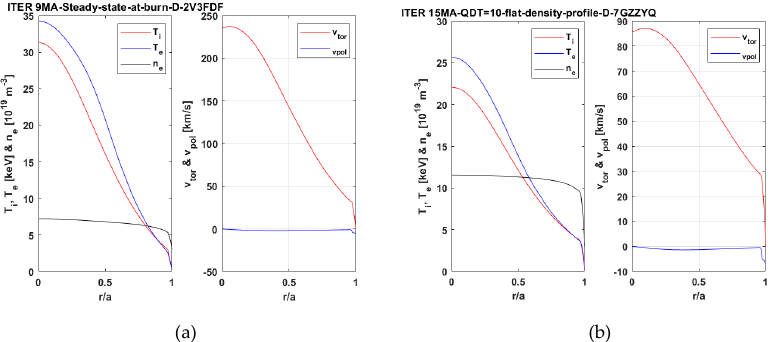
Figure 1. ( a ) ITER plasma profiles used for ADAS data 9MA_Steady_state_at_burn_D_2V3FDF; ( b ) High-density case: ITER plasma profiles 15MA_QDT=10_flat_density_profile_D_7GZZYQ.